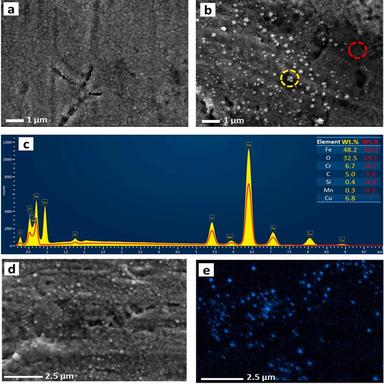
The SEM images of the surface before (a) and after the application of conversion treatment (b), the EDX spectra of marked zones on panel b (c), d, e) The SEM image of the treated sample (d) and the corresponding Cu EDX map (e).